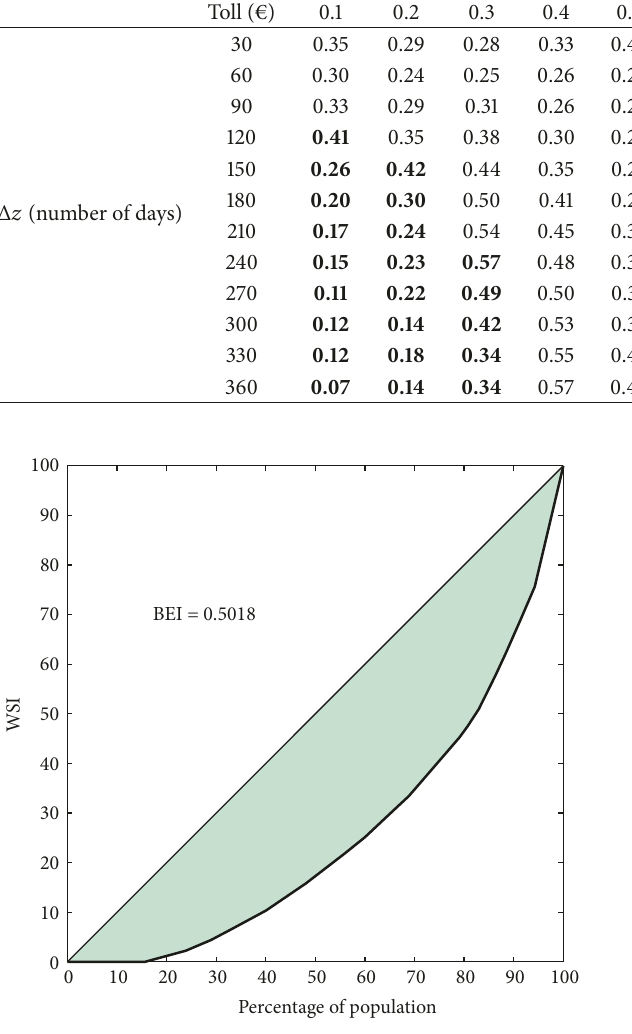
Figure 6: Scenario (1) : Lorenz curve and resulting BEI calculated with 𝑀 .